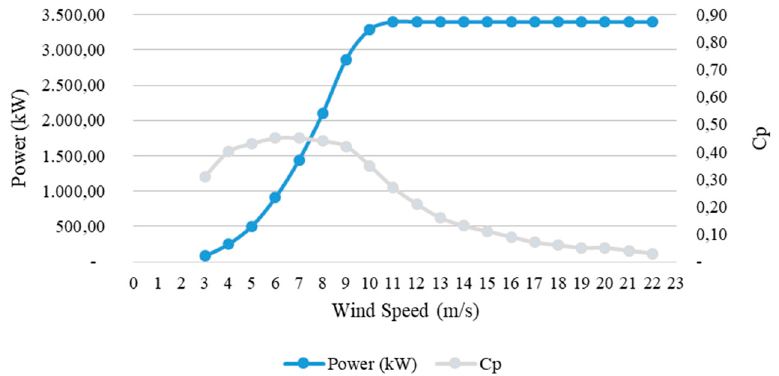
Figure 5. Wind turbine power curve. Table 8. Energy production for a single wind turbine (rotor diameter: 140 m). Wind Speed (m / s)